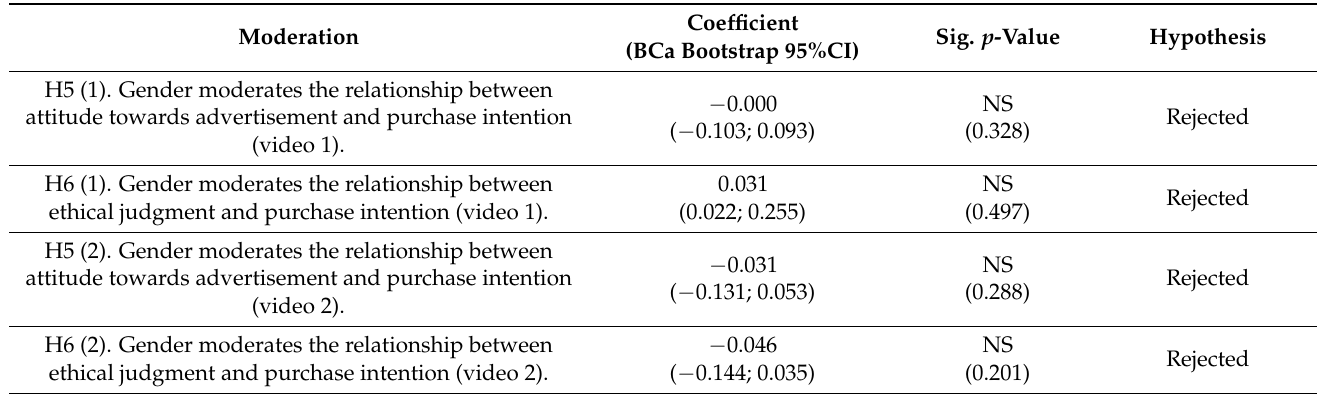
Table 4. Moderation analysis (video 1 and video 2).